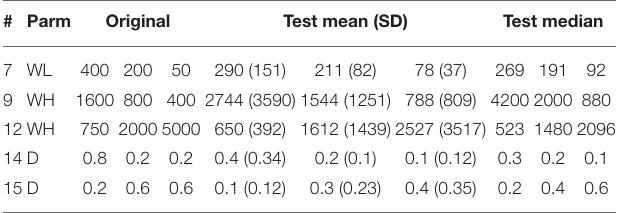
TABLE 3 | Table of the in-depth test results for five of the six randomly selected questions, and to the left are the original three values for the parameter in focus for each